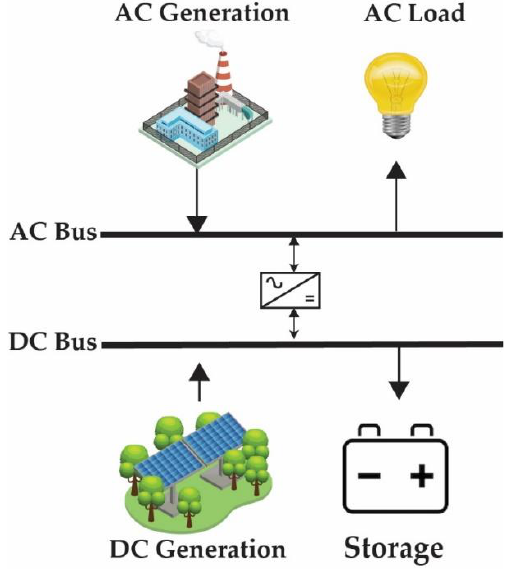
Figure 7. The hybrid bus architecture of campus microgrids.